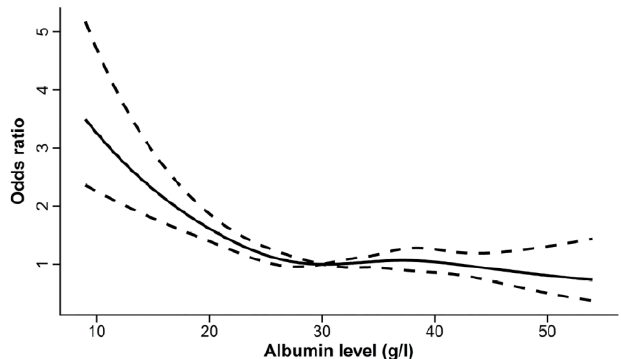
Figure 3. The relationship between serum albumin level and the risk of ICU mortality assessed by restricted cubic splines in a retrospective cohort study of 18,353 patients from the Medical Information Mart for Intensive Care IV (MIMIC-IV) database. The odds ratio of mortality is shown on the y -axis. The risk of mortality increases progressively when initial serum albumin levels are lower than 30 g/L. Reproduced without modification from Jin et al. 2022 [31] (accessed on 22 October 2022),